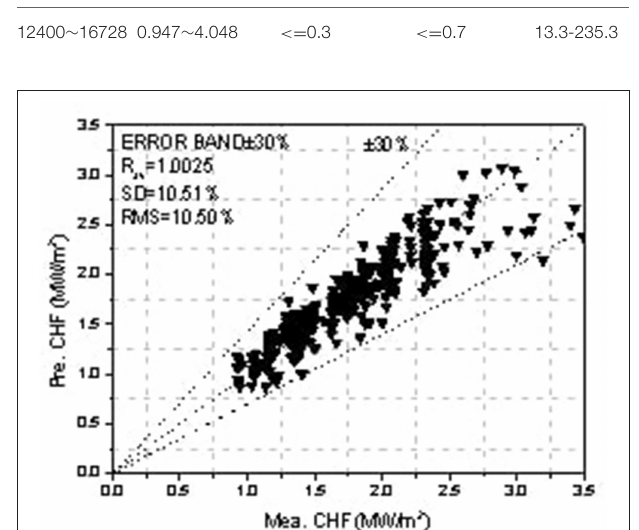
FIGURE 6 | Comparison of predicted and experimental CHF values by